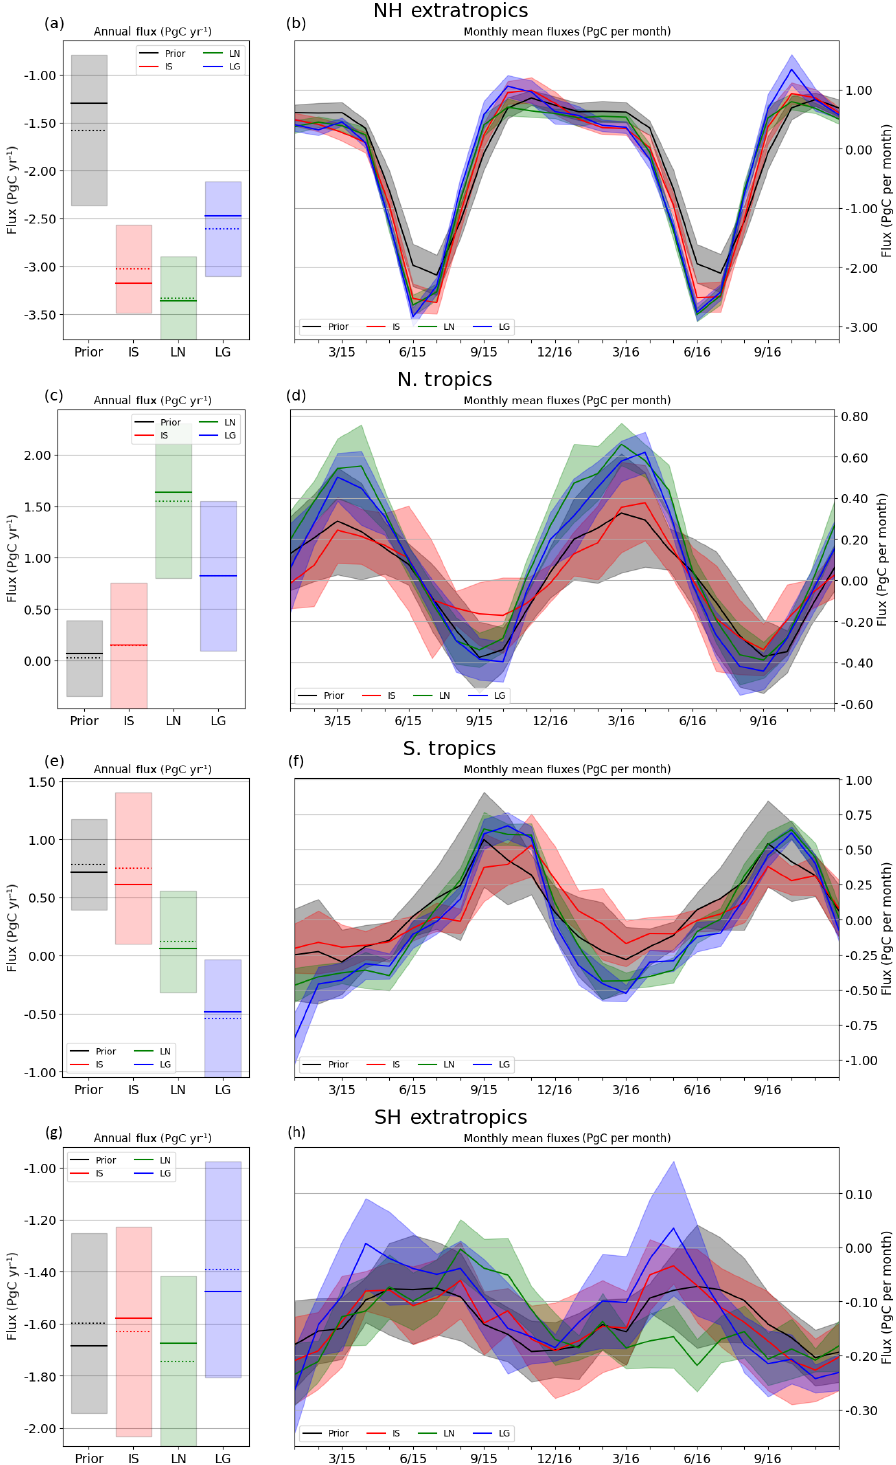
Figure 4. As in Fig. 3, but for zonal regions described by intervals of latitude: 23–90 ◦ N (Northern Hemisphere extratropics), 0–23 ◦ N (northern tropics), 23 ◦ S–0 ◦ (southern tropics), 90–23 ◦ S (southern hemisphere extratropics). As in the case of global land, posterior net fluxes in the northern extratropics all demonstrate a larger peak drawdown as well as a different seasonality from the prior, with the net drawdown period beginning earlier and ending earlier. The satellite retrievals imply a much more dynamic seasonality than either the prior or the in situ-constrained fluxes, particularly in the tropics, where the amplitudes of the seasonal cycles are significantly larger.